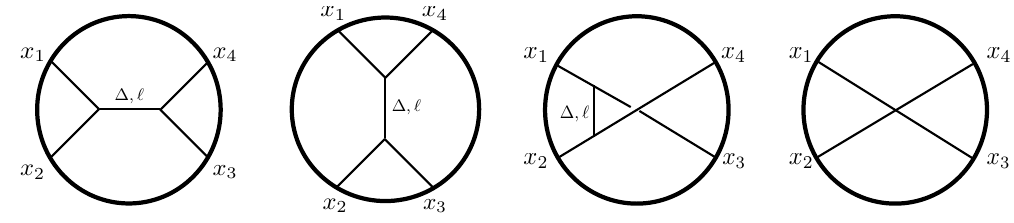
Figure 3 . Here we show the Witten exchange diagrams (exchanging a bulk operator of dimension ∆ and spin ‘ = 0 , 1 ) in AdS 2 out of which a Polyakov block is built. The fourth diagram indicates specific (crossing symmetric) contact diagram contributions which need to be added to the Polyakov block for reasons discussed in section